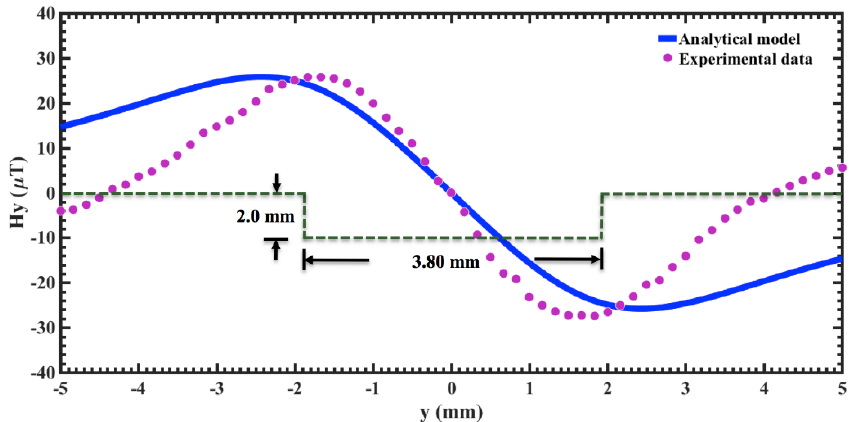
Figure 8. Normal MMM signal of the rectangular defect S2 of the ASTM A-36 steel pipe.